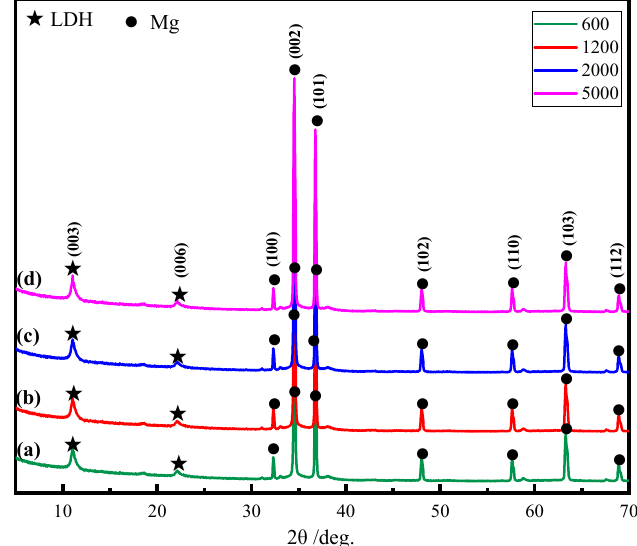
Figure 3. XRD patterns of ZnAl-LDH films grown on AZ91D Mg alloy with different surface roughness: ( a ) 600; ( b ) 1200; ( c ) 2000; ( d ) 5000.